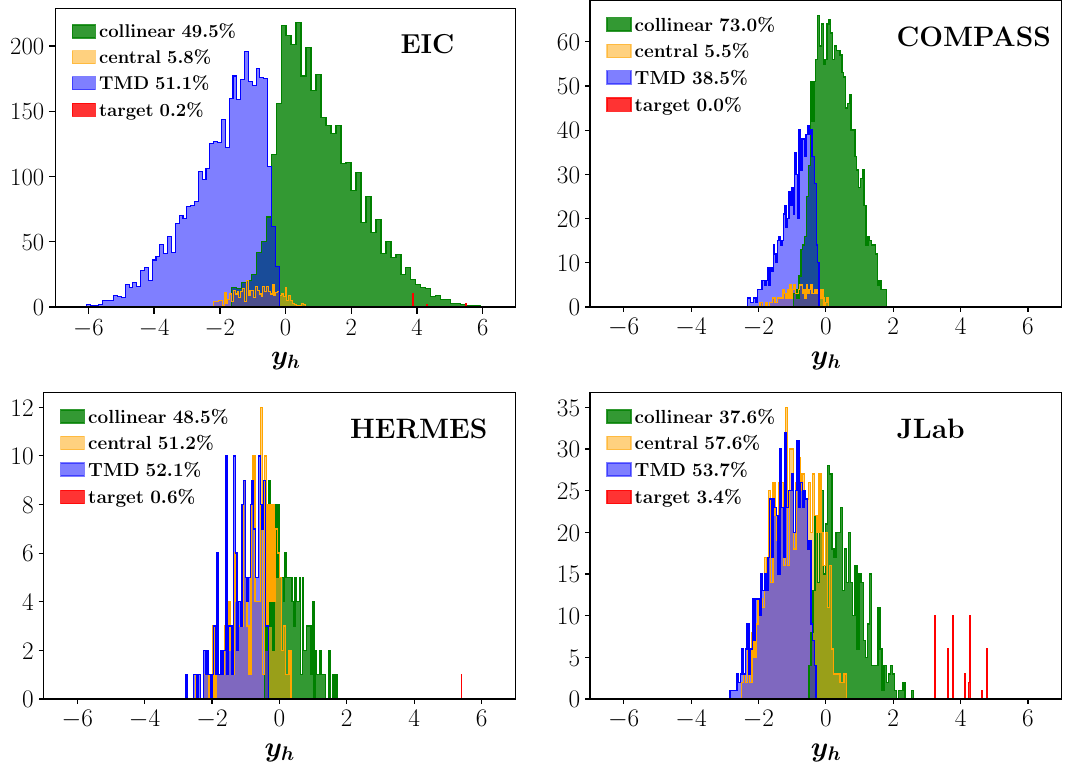
Figure 4 . Phase space in rapidity y h of produced hadrons at EIC, COMPASS, HERMES, and Jefferson Lab kinematics, with for TMD (blue), collinear (green), central (yellow) and target (red) regions indicated. The legends show the percentage of all bins with corresponding affinity above